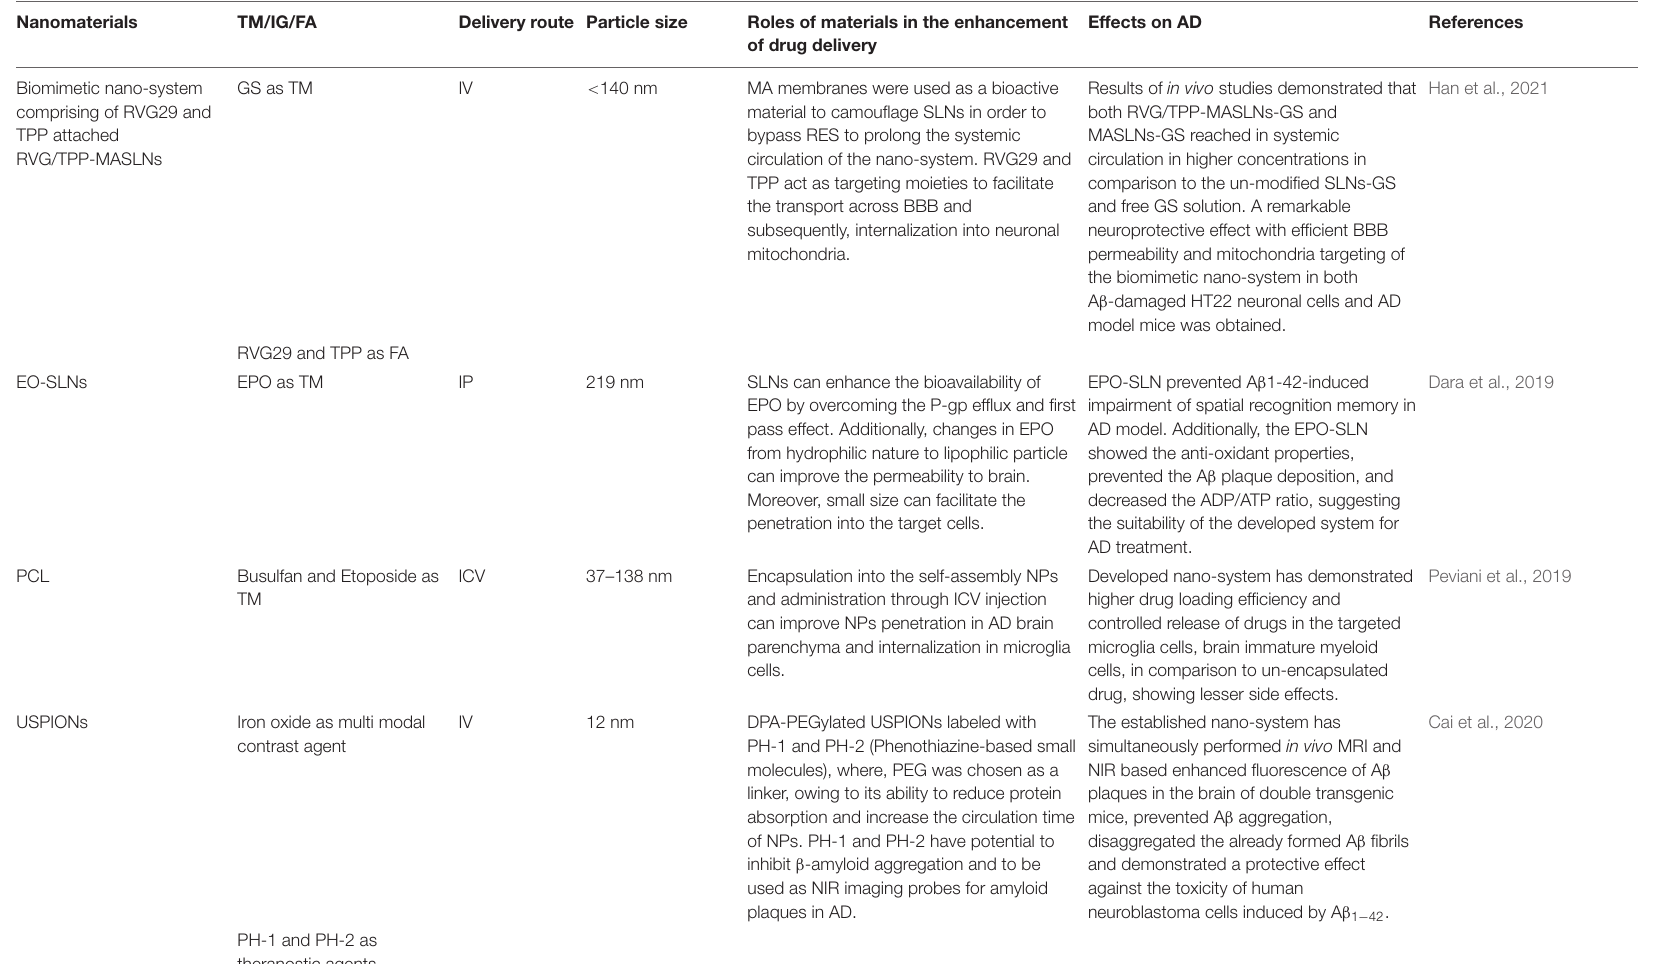
TABLE 1 | The applications of functionalized nanomaterials for delivering therapeutic moieties and imaging agents to brain for managing AD related